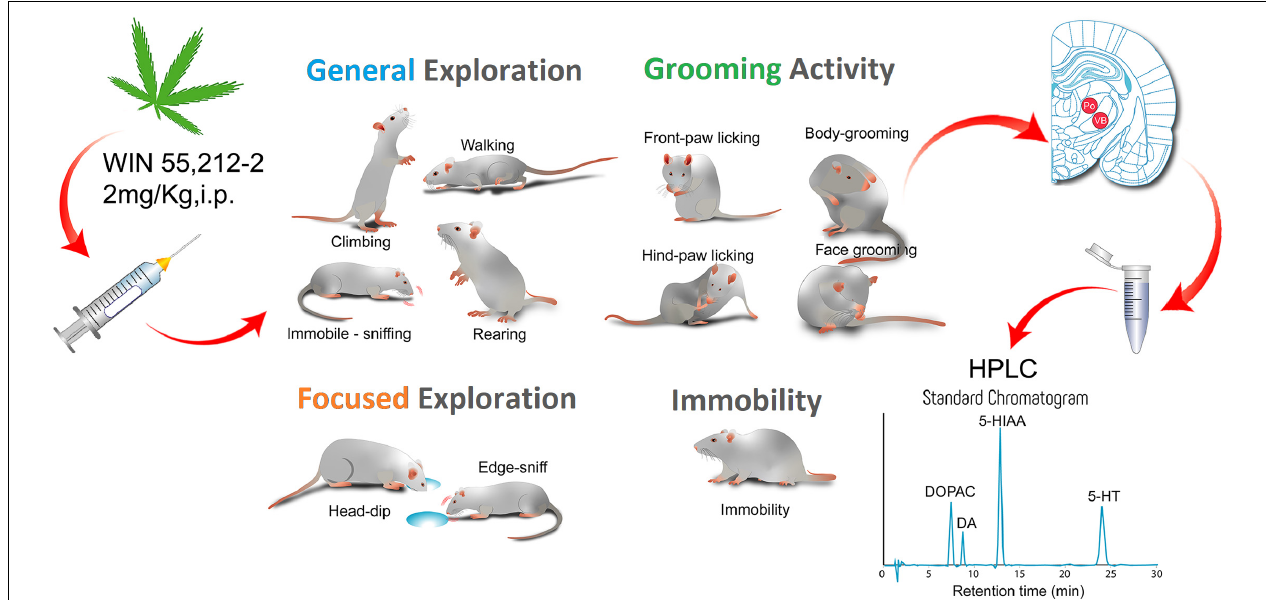
FIGURE 1 | Graphical abstract summarizing the main aspects of the study. Adult male GAERS and NEC received an IP administration of 2 mg/kg of the CB1/2 receptor agonist WIN 55,212-2 and 30 min after were placed into the arena of the hole-board test to study the effect of the cannabinoid receptor activation on the neophilia and emotional behavior of the two inbred strains. We measured General Exploration, Focused Exploration, Grooming activity, and Immobility. We analyzed the data by quantitative and T-Pattern analysis. Different groups of animals received the same pharmacological treatment and after the 30 min from the injection their brains were removed and frozen for HPLC analysis of the monoamines dopamine (DA), noradrenaline and serotonin (5-HT) and some of their metabolites (3,4-Dihydroxyphenylacetic acid, DOPAC; 5-hydroxyindoleacetic acid, 5-HIAA). WIN 55,212-2 reduced motor behavior but did not affect emotionality of the epileptic GAERS rats and produced neurochemical changes in the hippocampus and basal